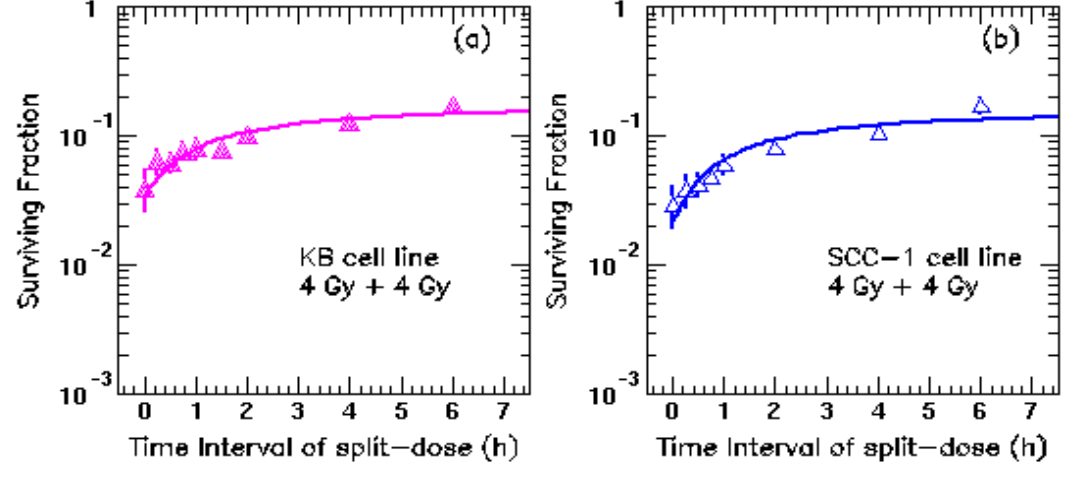
Figure 1. Fitted cell sublethal repair curves using split-doses exposure of 8 Gy. ( a ) KB cell line, the fitting yields: α / β = 8.3 ± 4.1 Gy, α = 0.22 ± 0.08 Gy − 1 with repairtime T = 18 ± 21 min; ( b ) the fitted results for UMSCC-1 cell line: α / β = 7.9 ± 5.1 Gy, r α = 0.23 ± 0.10 Gy − 1 with repair halftime T HNC cells.